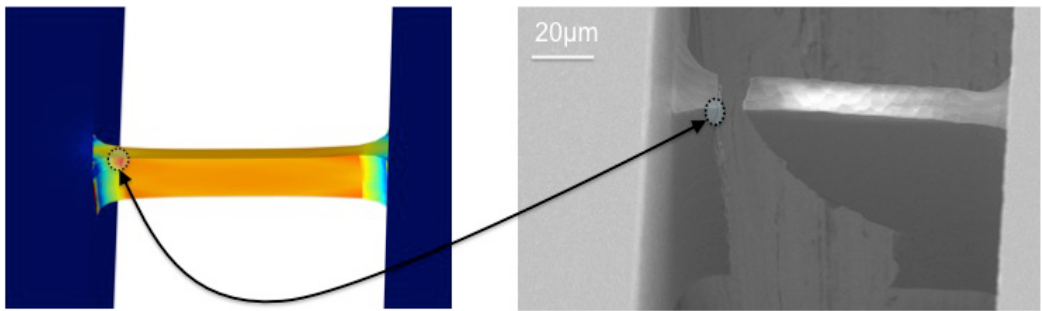
Figure 13. Tested specimen under the scanning electron microscope ( right ) and a virtual experiment using finite element analysis simulation software illustrated ( left ). The circled area has a stress concentration factor of 1.15.